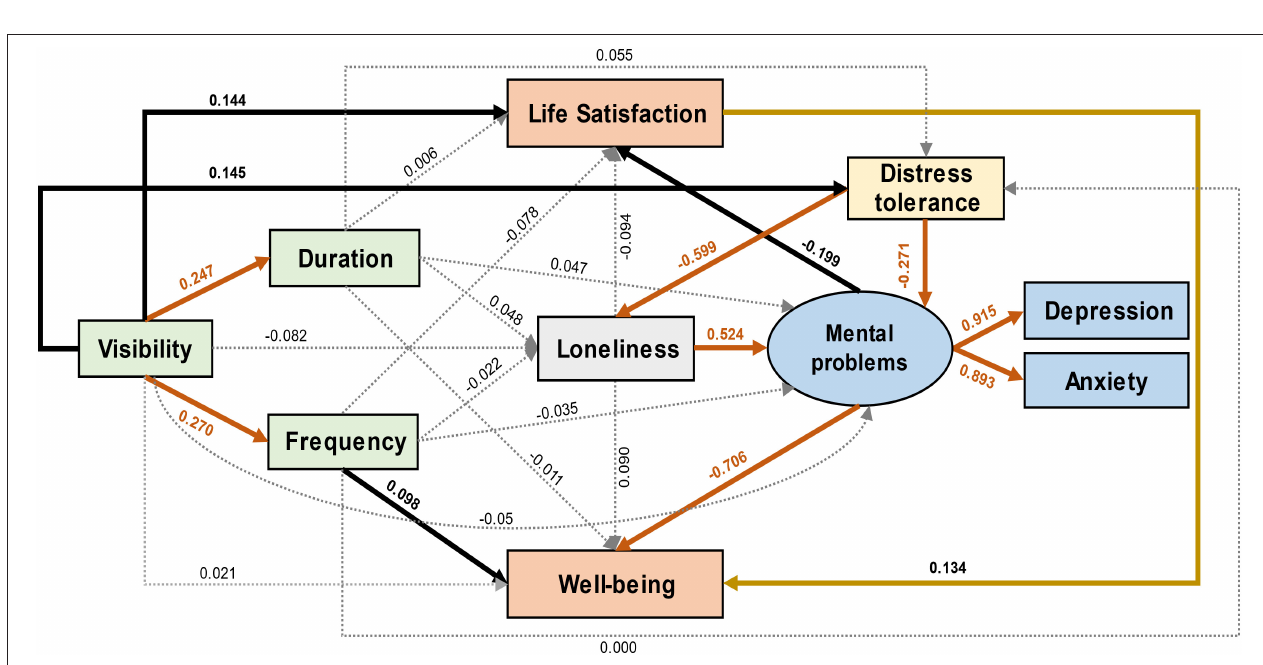
FIGURE 3 | The final SEM model demonstrates standardized effects between variables. The black solid lines indicate p < 0.05, the yellow solid line indicates p < 0.01, the red solid lines indicate p < 0.001, and the dotted lines indicate p >